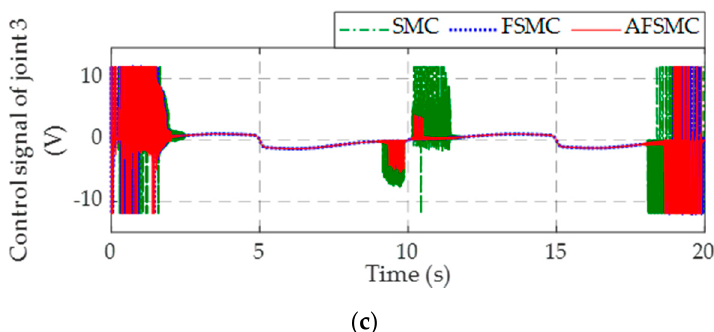
Figure 15. The control signal acting on the: ( a ) first joint, ( b ) second joint, and ( c ) third joint.